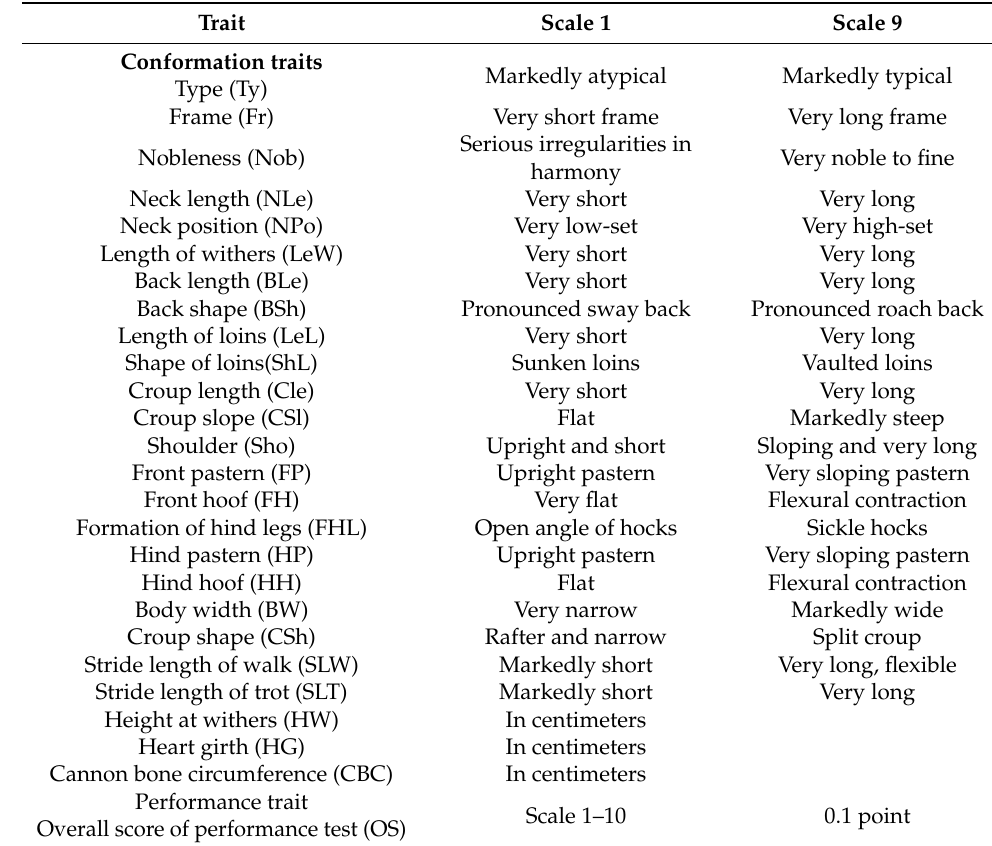
Table 1. Description of the conformation and performance traits used for the entry of horses into a